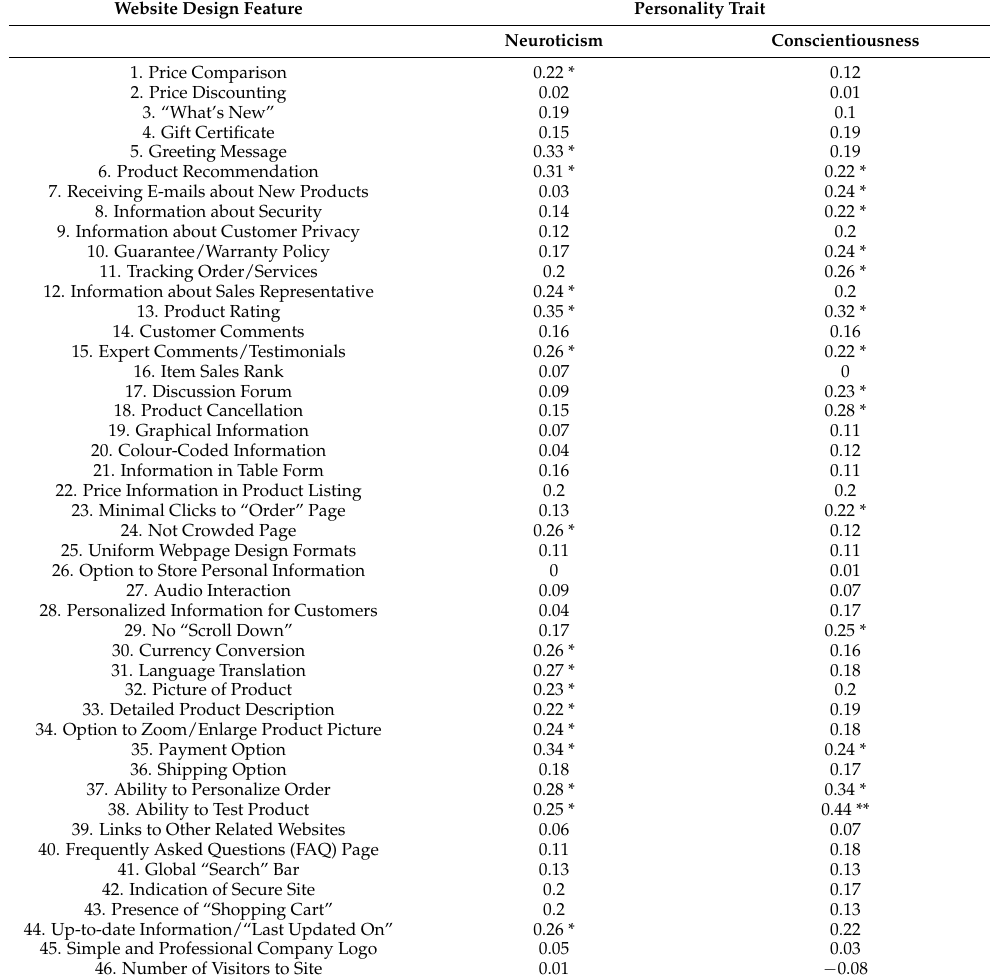
Table 5. Correlations between the Variables ( n = 89). Website Design Feature Personality Trait Neuroticism